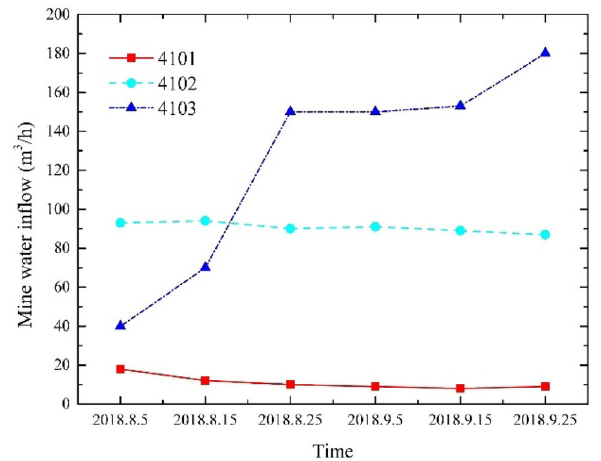
Fig. 10 Working face mine-water inflow curve